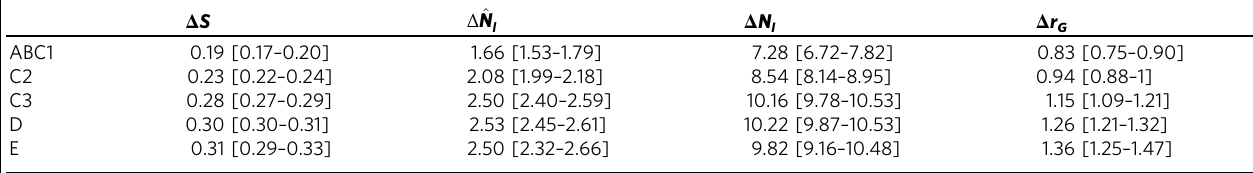
Table 1 Estimation statistics of gender differences in mobility, disaggregated by users ’ socioeconomic group (GSE).